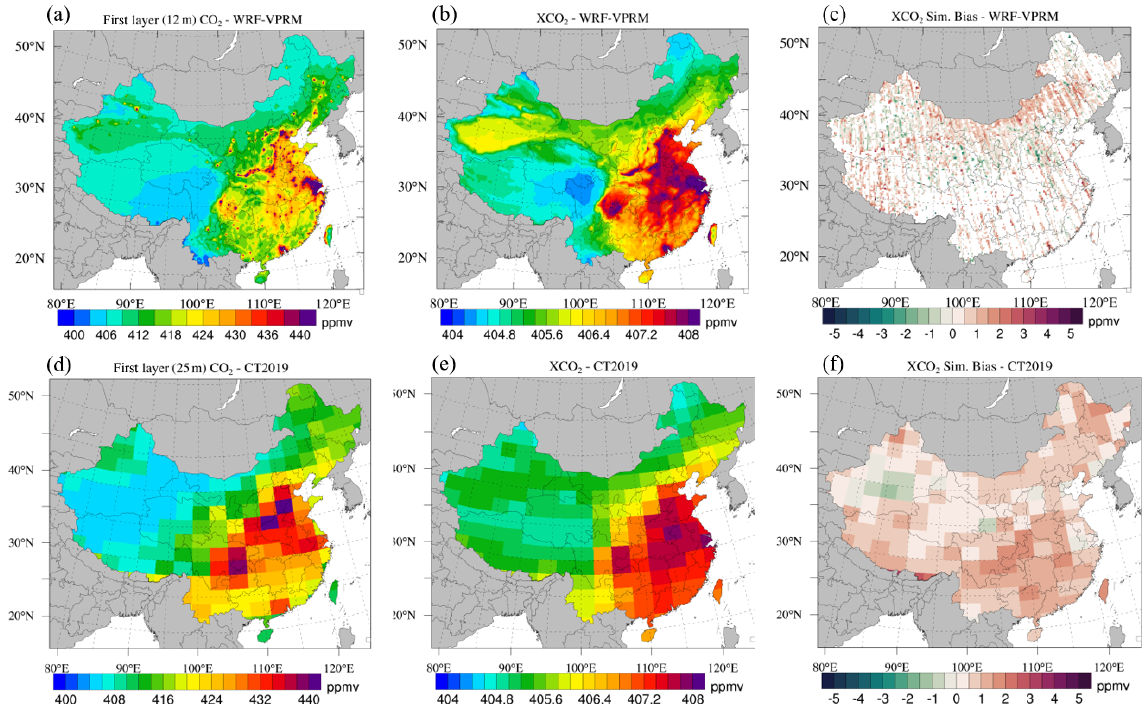
Figure 3. 2016–2018 averages of WRF-Chem simulations of (a) first-layer (mid-level height is 12km) CO 2 concentration and (b) XCO 2 concentration. (c) WRF-Chem-simulated XCO 2 bias against OCO-2. Panels (d) – (f) are the same as (a) – (c) but for CT2019 (first-layer mid-level height is